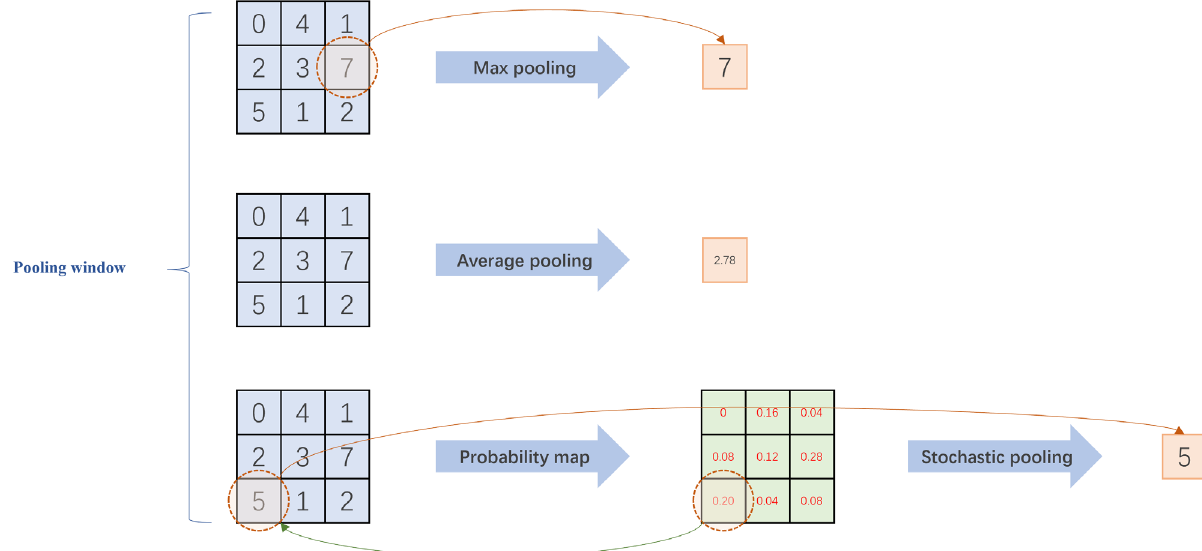
Figure 2. Comparison of max pooling, average pooling, and stochastic pooling .